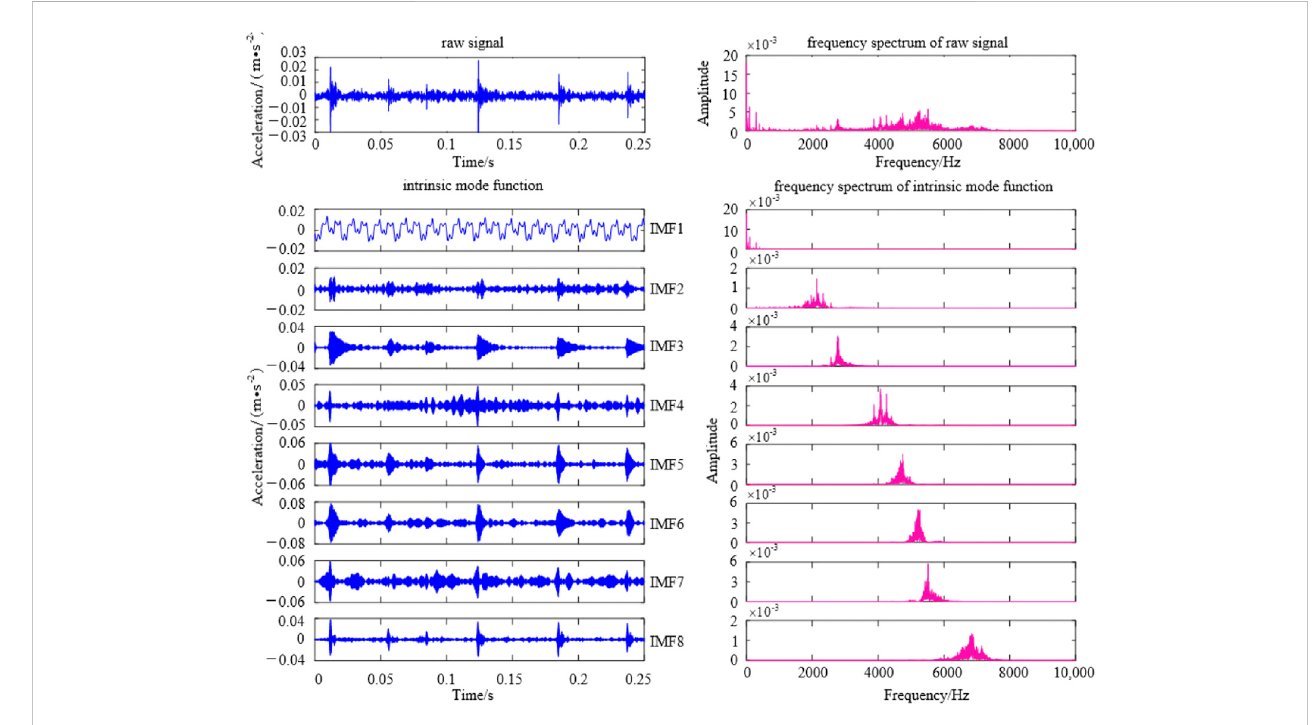
FIGURE 8 Time-frequency diagram of IMF components.